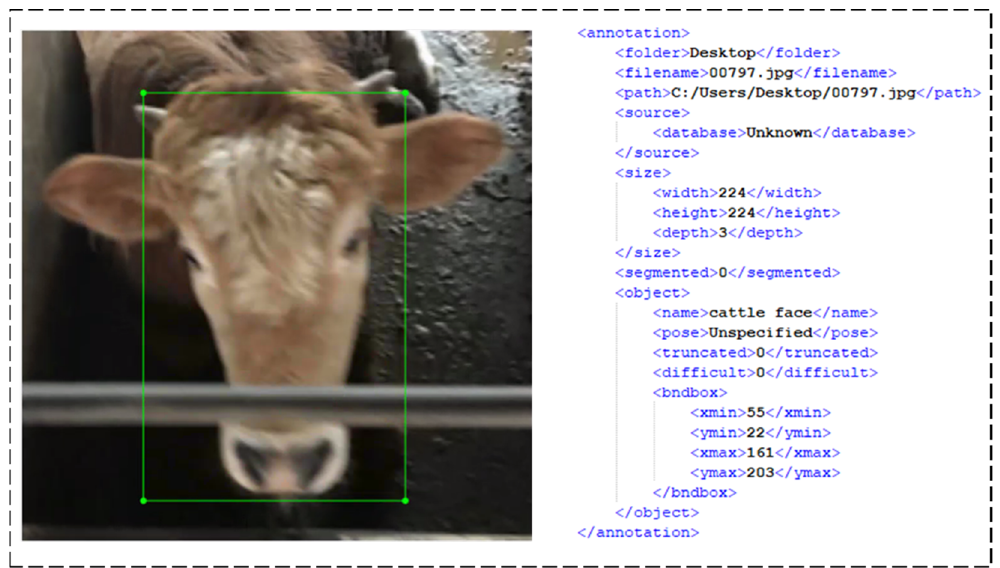
Figure 4. Example of annotation (green) for cattle face and details of a labeled cattle face.